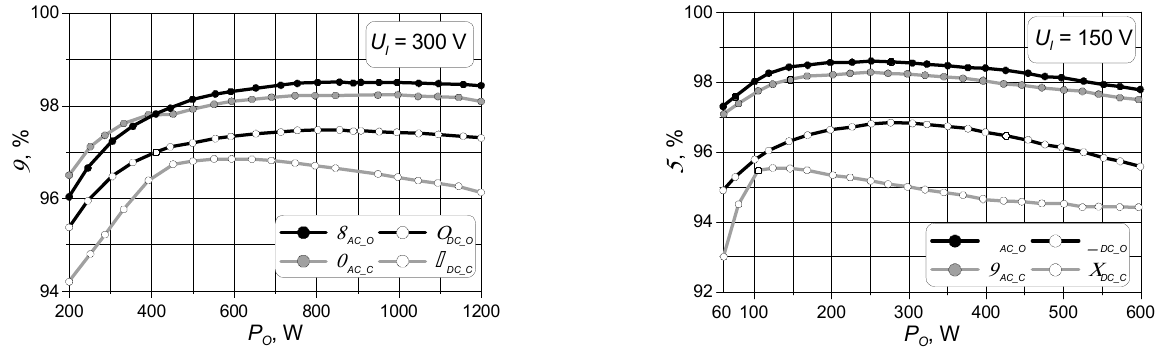
Figure 8. AC/AC and DC/DC efficiencies as a function of output power ( U I = 300 and 150 V). The output voltage measurements under analogous experimental conditions are shown in Figure 9. Both open-loop ( U O_O ) and closed-loop ( U O_C ) operations are included. As predicted by the MCR circuit analysis, U O_O is approximately 10% higher than U O_C . The output voltage U O was also calculated using Equation (12). These theoretical characteristics are within 1% of the measurements (Figure 9).